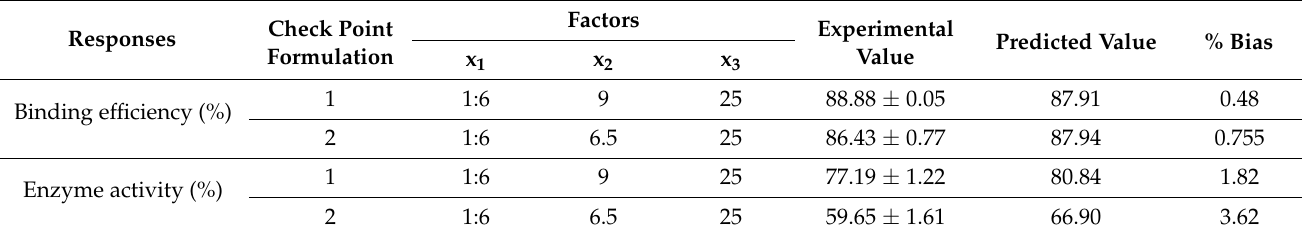
Table 5. The experimental and predicted values of the responses of the optimized complex LYS:SDS. Data are presented as mean ± SD ( n = 3).